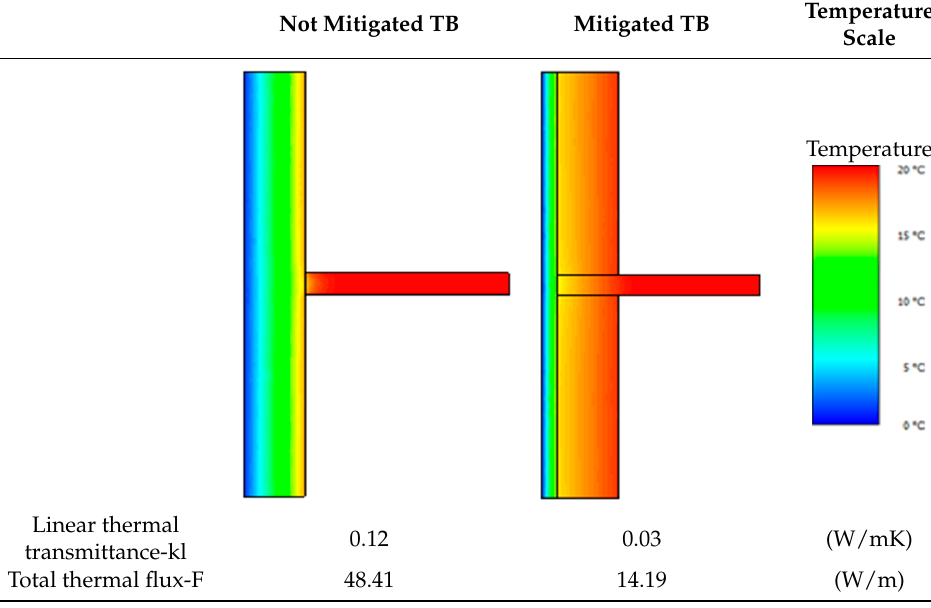
Table 8. IW Thermal bridges.